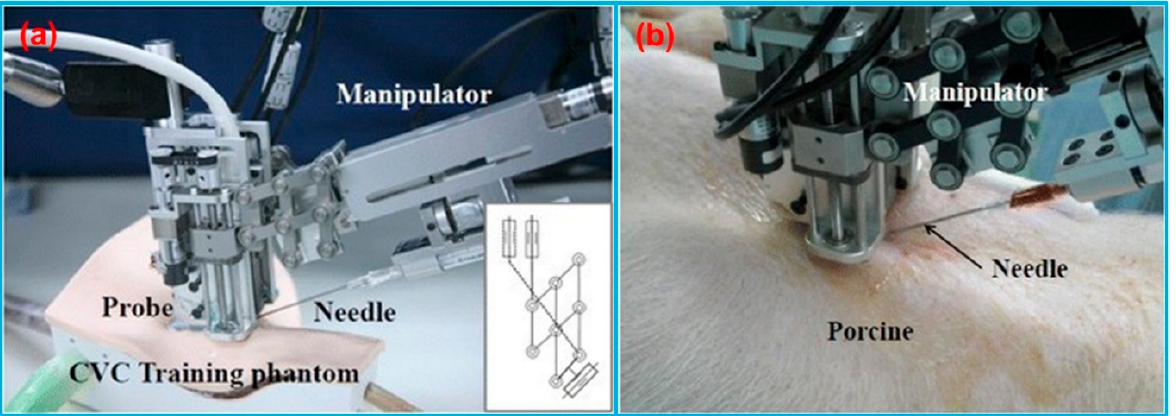
Figure 18. ( a ) Needle insertion manipulator for central venous catheterization. ( b ) Overview of venous puncture experiment in a porcine model. Reprinted from [182] with permission.